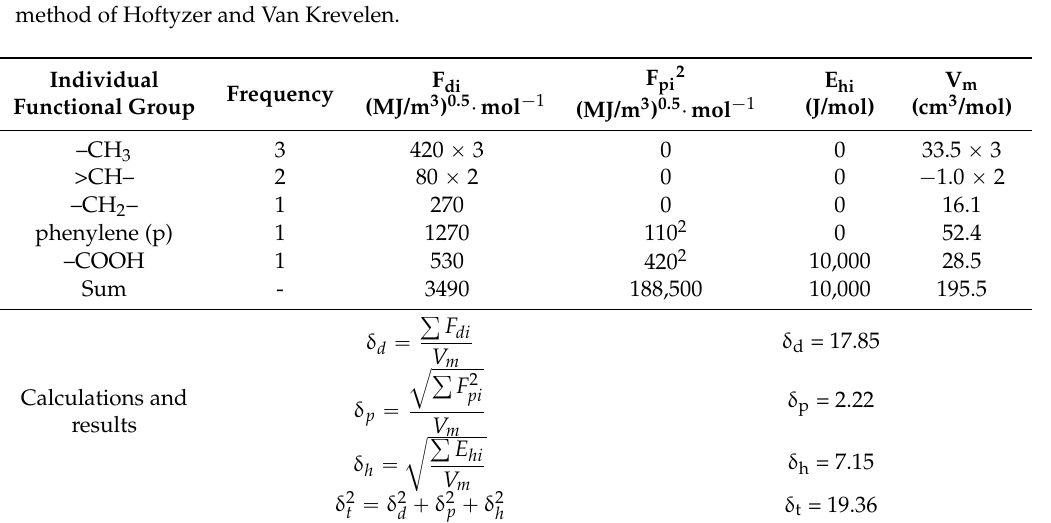
Table 7. Calculation of solubility parameters for the drug ibuprofen, using the group contribution method of Hoftyzer and Van Krevelen.